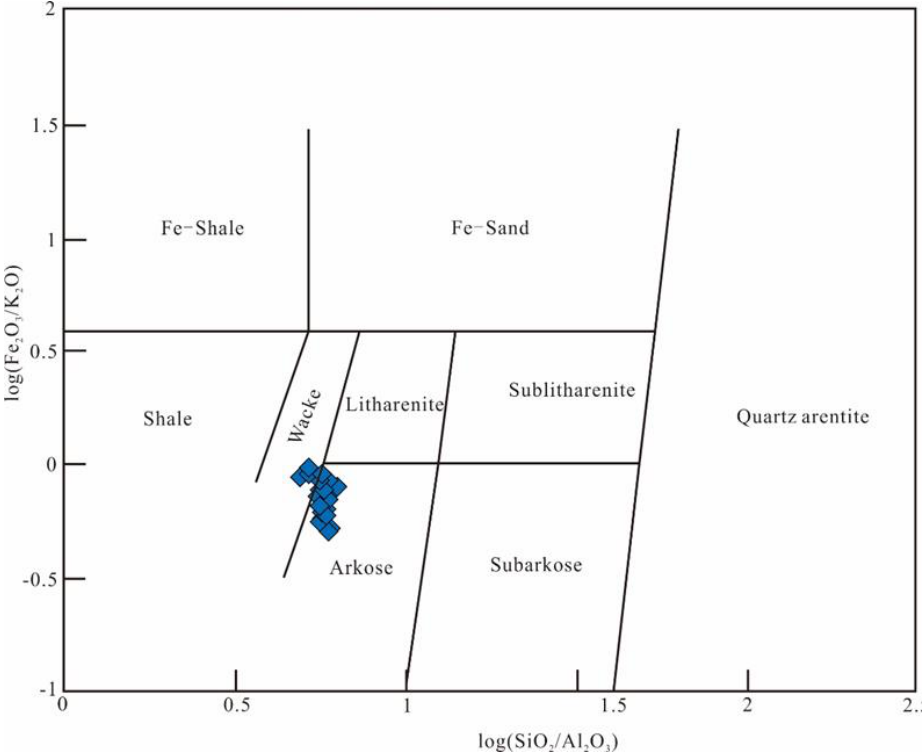
Figure 4. Geochemical classification diagram [32] of log(Fe 2 O 3 /K 2 O) plotted against log (SiO 2 /Al 2 O 3 ) for sandstones from the Zhiluo Formation.